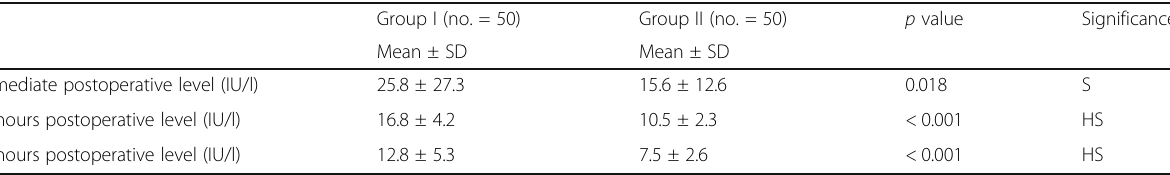
Table 4 Postoperative CK-MB level (IU/l)